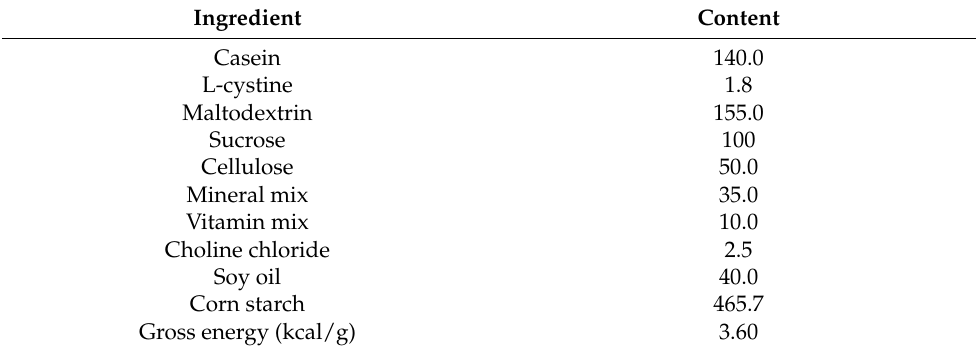
Table 1. Diet composition (g/kg